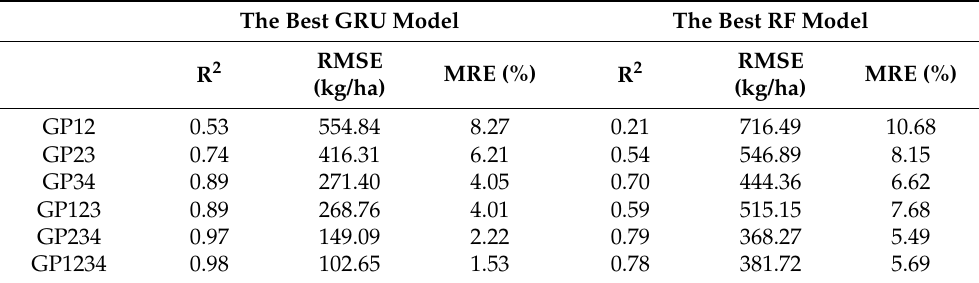
Table 6. Optimal Yield Prediction Model for Combinations of Different Growth Periods.